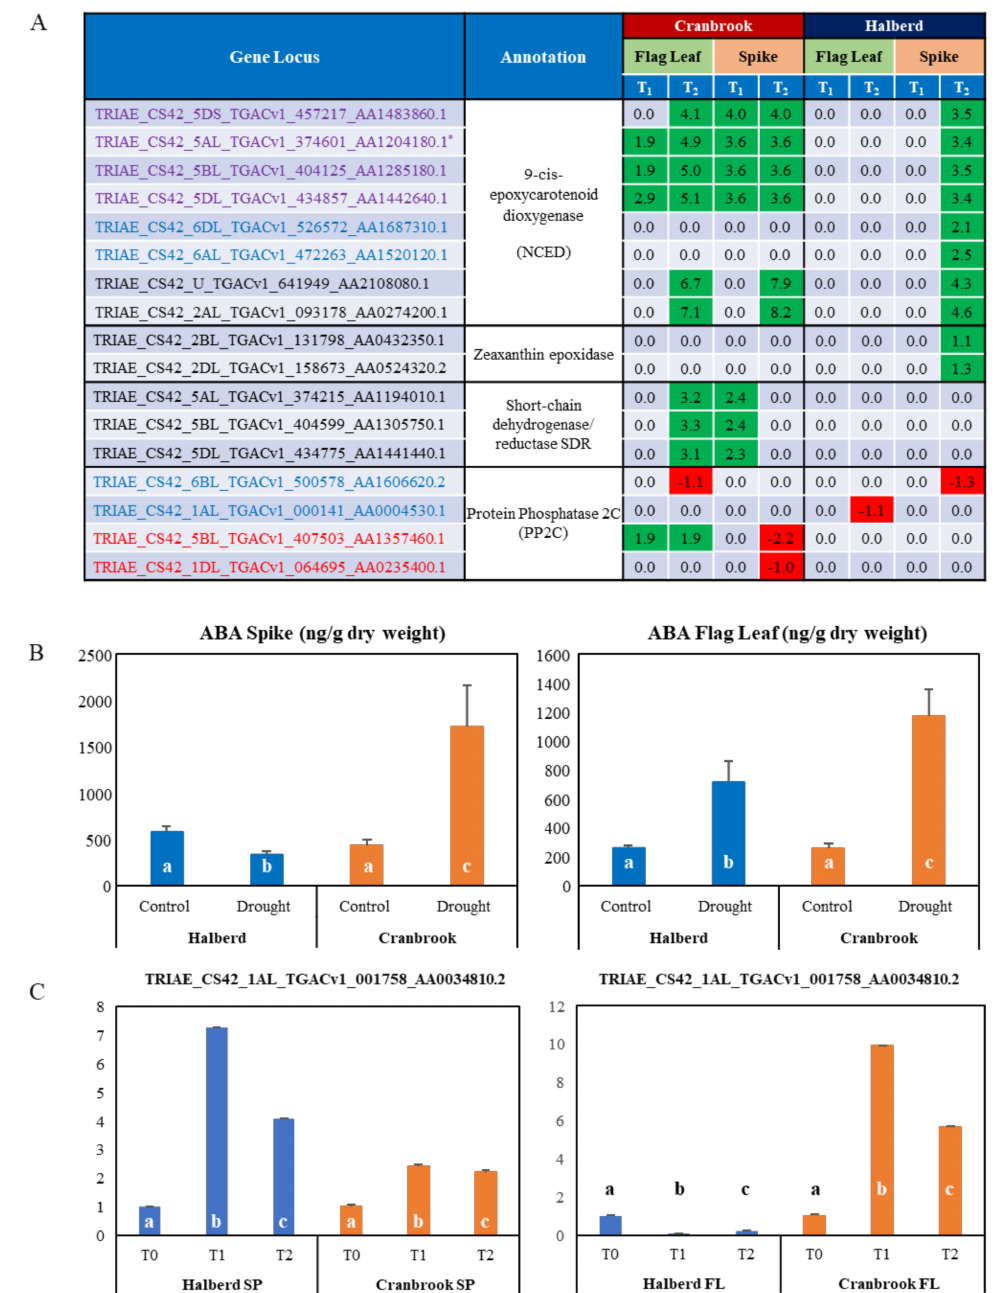
Figure 6. ( A ) List of genes involved in ABA synthesis and signaling. The NCED and PP2C genes were significantly enriched; gene loci in blue and red are specifically enriched in Halberd and Cranbrook, loci in purple are enriched in both wheat lines. Other potential ABA biosynthetic genes encoding zeaxanthin epoxidase and short-chain dehydrogenase/reductases were also amongst the DEG and were added to the list. The TaNCED2 gene used for expression analysis in Figure 1B is marked with an asterisk. The expression data are listed as Log FC values relative to unstressed plants (green = up-regulated; red = down-regulated). ( B ) Determination of ABA concentrations in control and drought-stressed Halberd and Cranbrook flag leaves and spikes. Average ABA levels are expressed in ng/g dry weight (Y-axis). Three repeats were used for each measurement and error bars are standard errors. ABA levels that are significantly different compared the Halberd unstressed control and compared to the other samples in the graph are labelled with different letters ( t -test; p < 0.05). ( C ) Real-time PCR expression studies of one candidate bZIP transcription factor gene. Three repeat samples were tested and error bars show standard errors. FL = flag leaf; SP = spike. Gene expression levels are relative to the unstressed control (=1) for each wheat line and bars in the graph labelled with different letters are significantly different ( t -test; p <